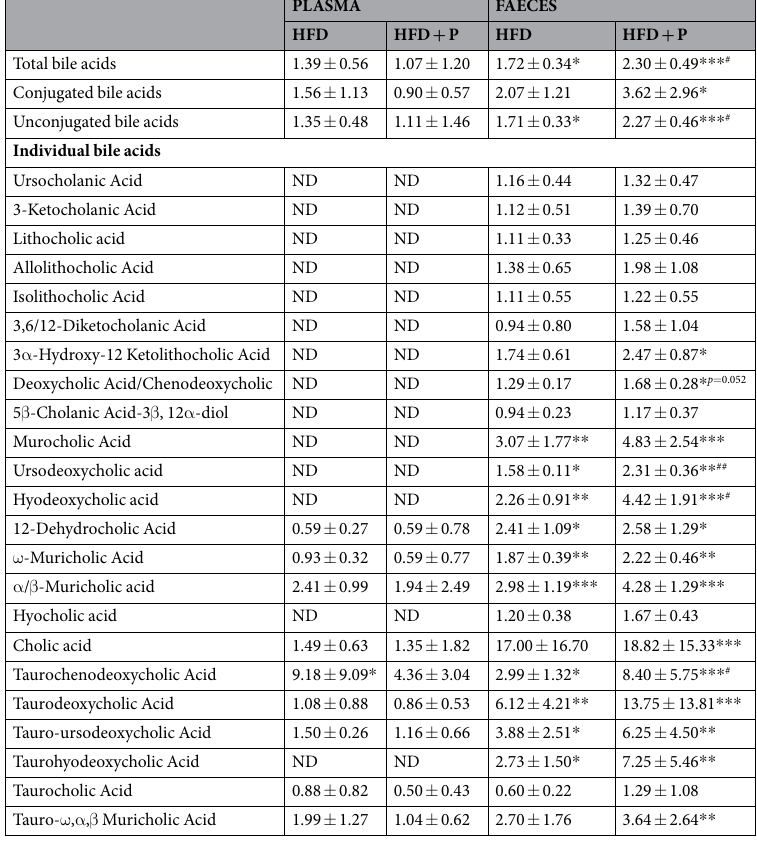
Table 2. Ratio of plasma and faecal bile acid content in relation to BL group. Data represent the means ± SD of 4 (plasma) or 6 (faeces) mice per group. Values of p were determined using one-way ANOVA with Tukey’s (equal variance) or Dunnett’s T3 (unequal variance) post-hoc analysis where ∗ p < 0.05, ∗∗ p < 0.01, and ∗∗∗ p < 0.001 versus the BL group; # p < 0.05, ## p < 0.01, and ### p < 0.001 versus the HFD group. Values of p compared to the HFD group are stated where appropriate. ND, not detected.